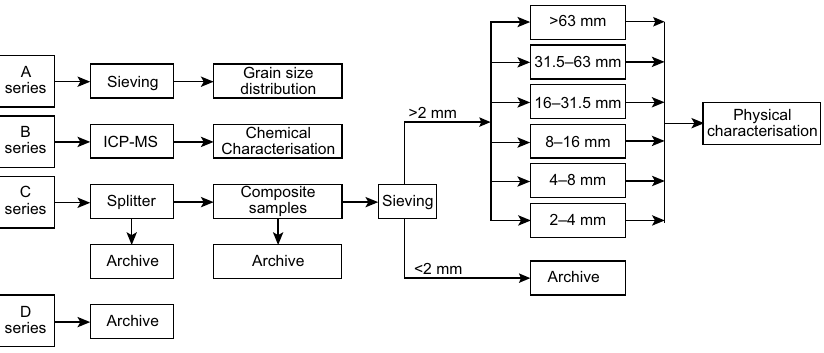
Fig. 2. Sampling workflow and methods applied to each series (A–D) of sampled IBA (modified from Clausen et al . 2019).